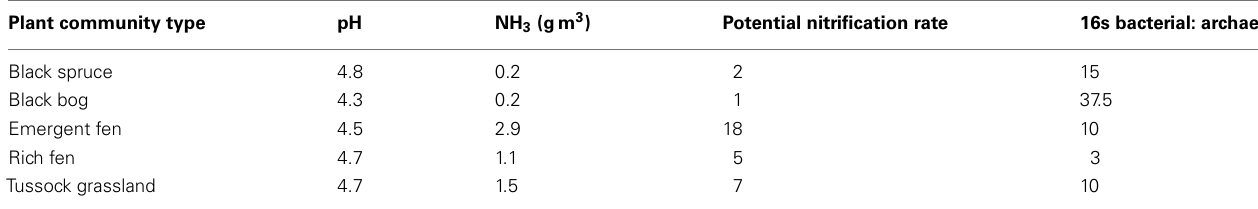
TableA1 | Initial inputs for model simulation of the Petersen dataset.